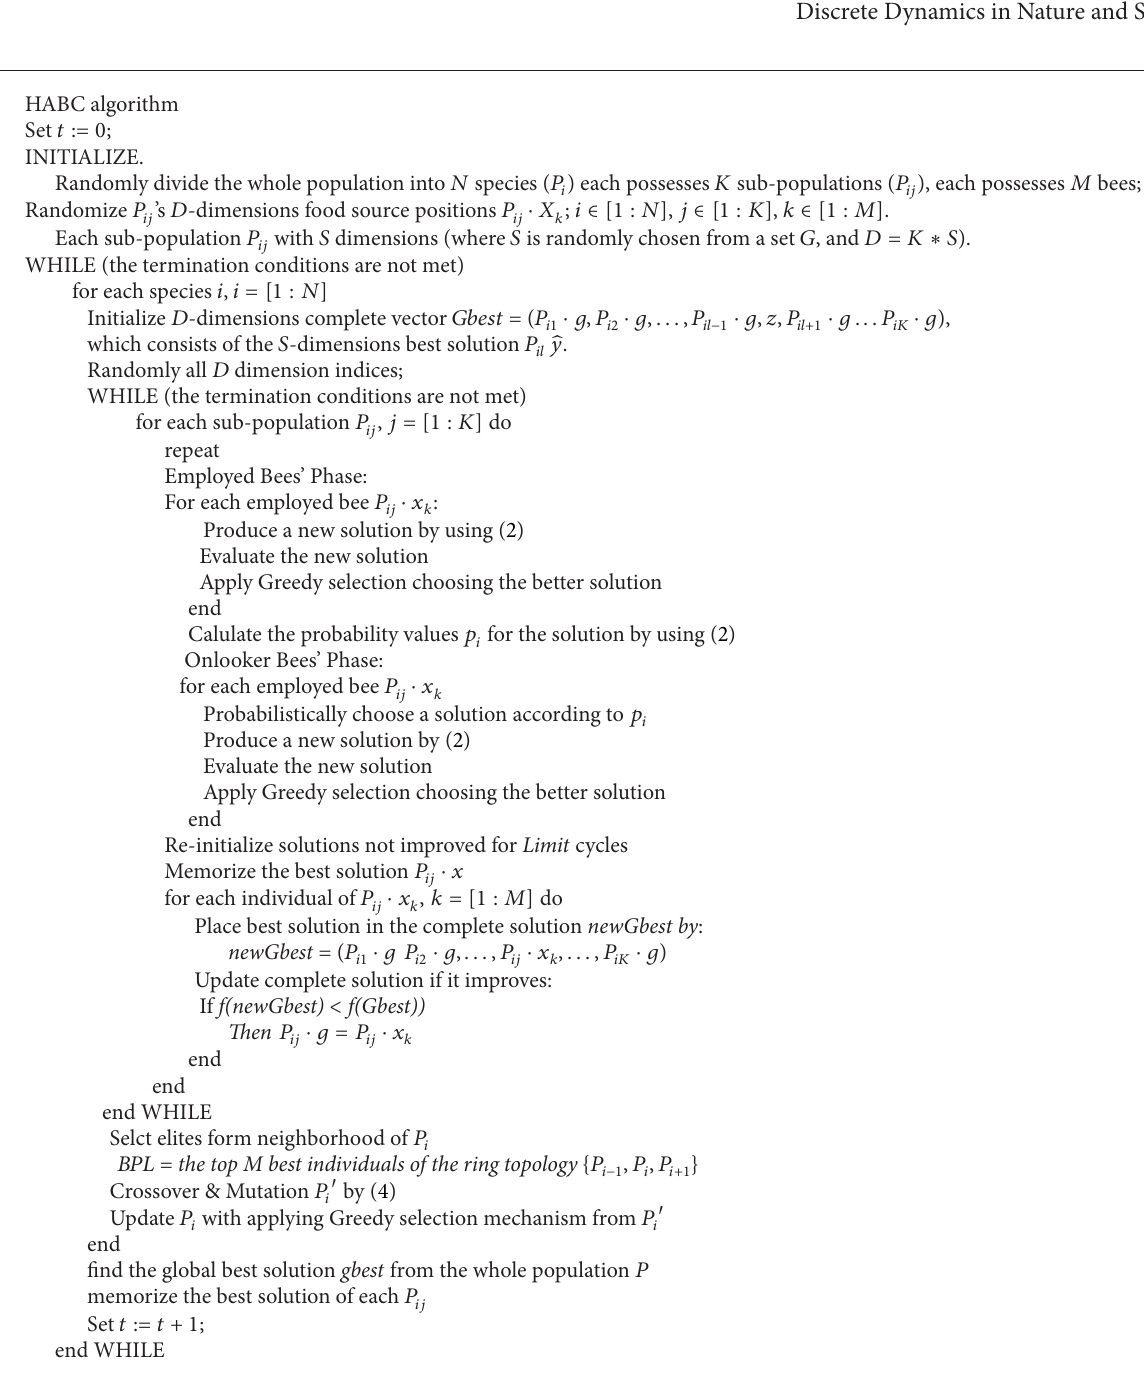
Pseudocode 1: Pseudocode for the HABC